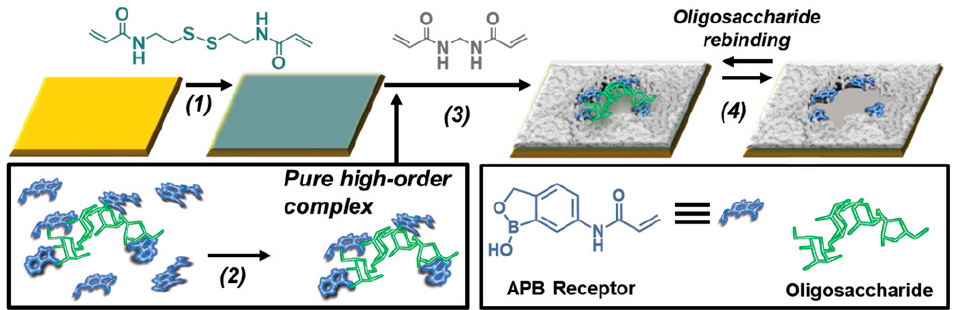
Figure 16. Method for creating synthetic materials with superselective glycan recognition. (1)